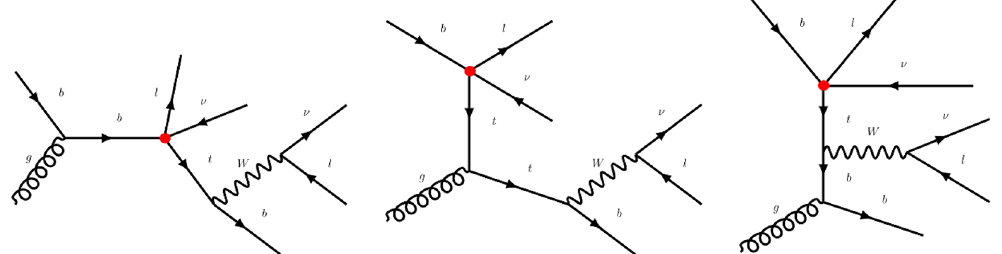
bl + (cid:23)l (cid:0) (cid:22) (cid:23) . !